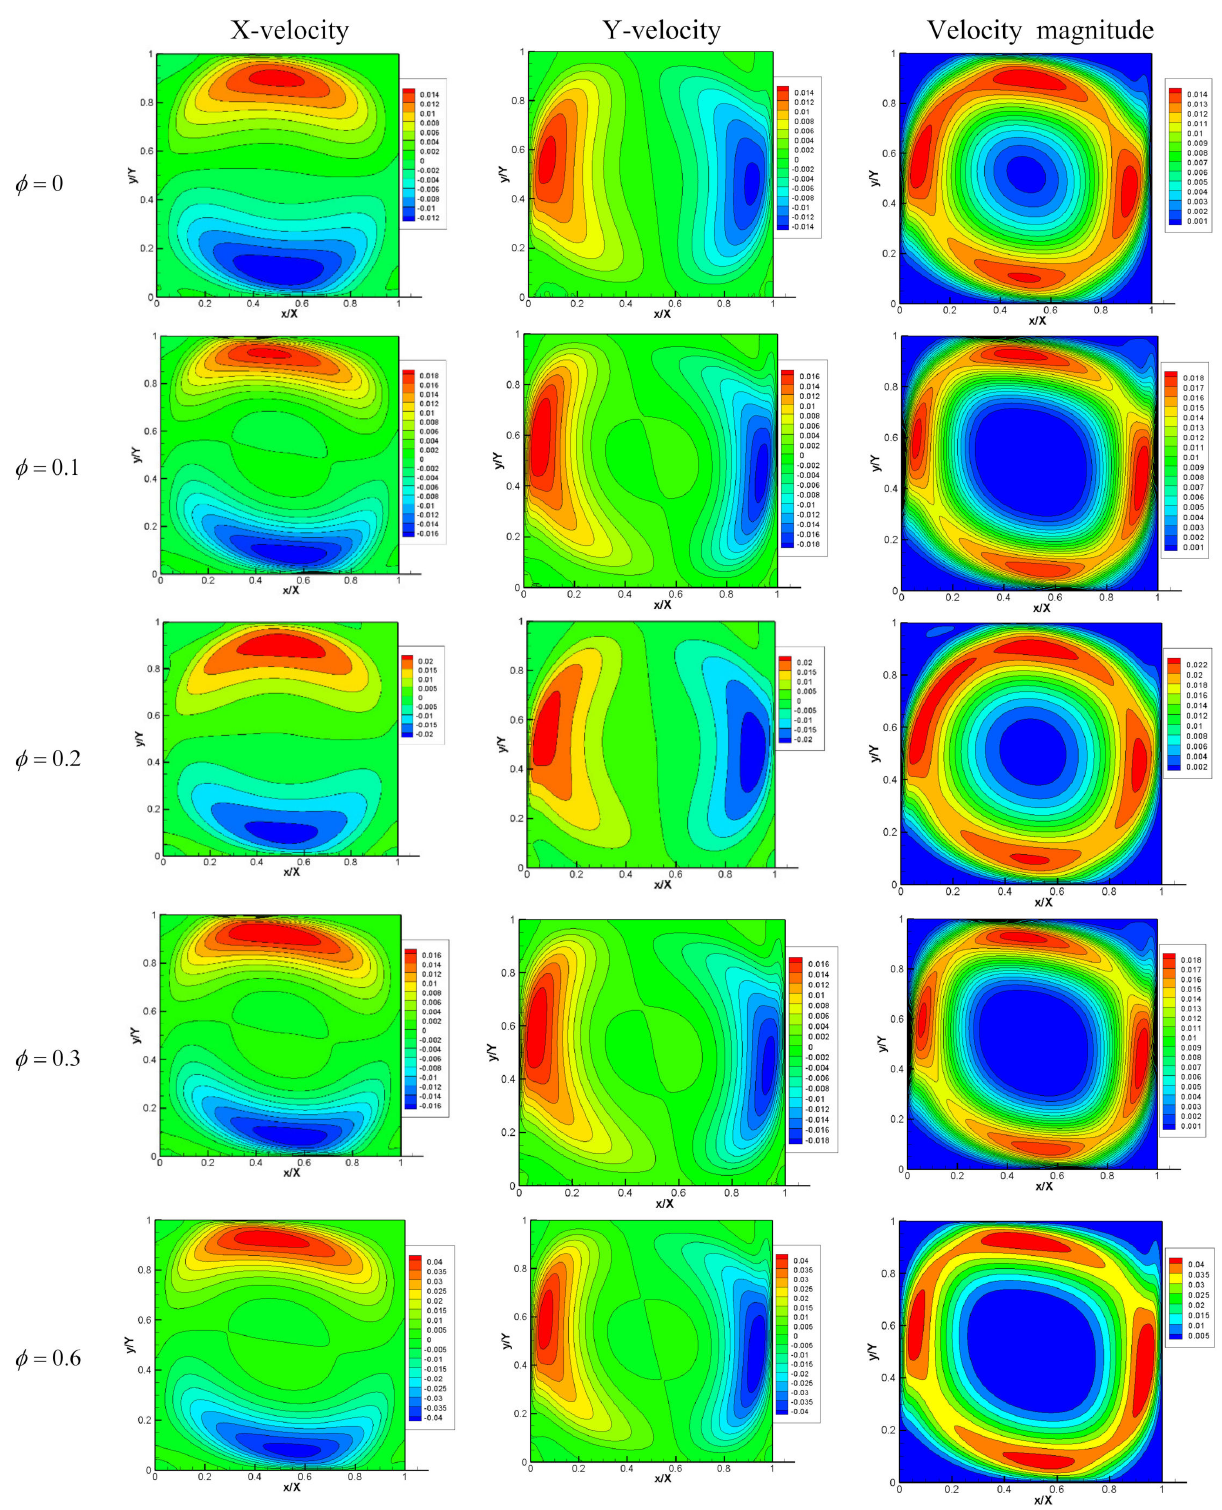
Figure 16. Steady state X-velocity, Y-velocity, and velocity magnitude profiles behavior for central partially left boundary conditions (case 3: sinusoidal boundary condition) at different volume fractions ( φ ) for Ra = 10 5